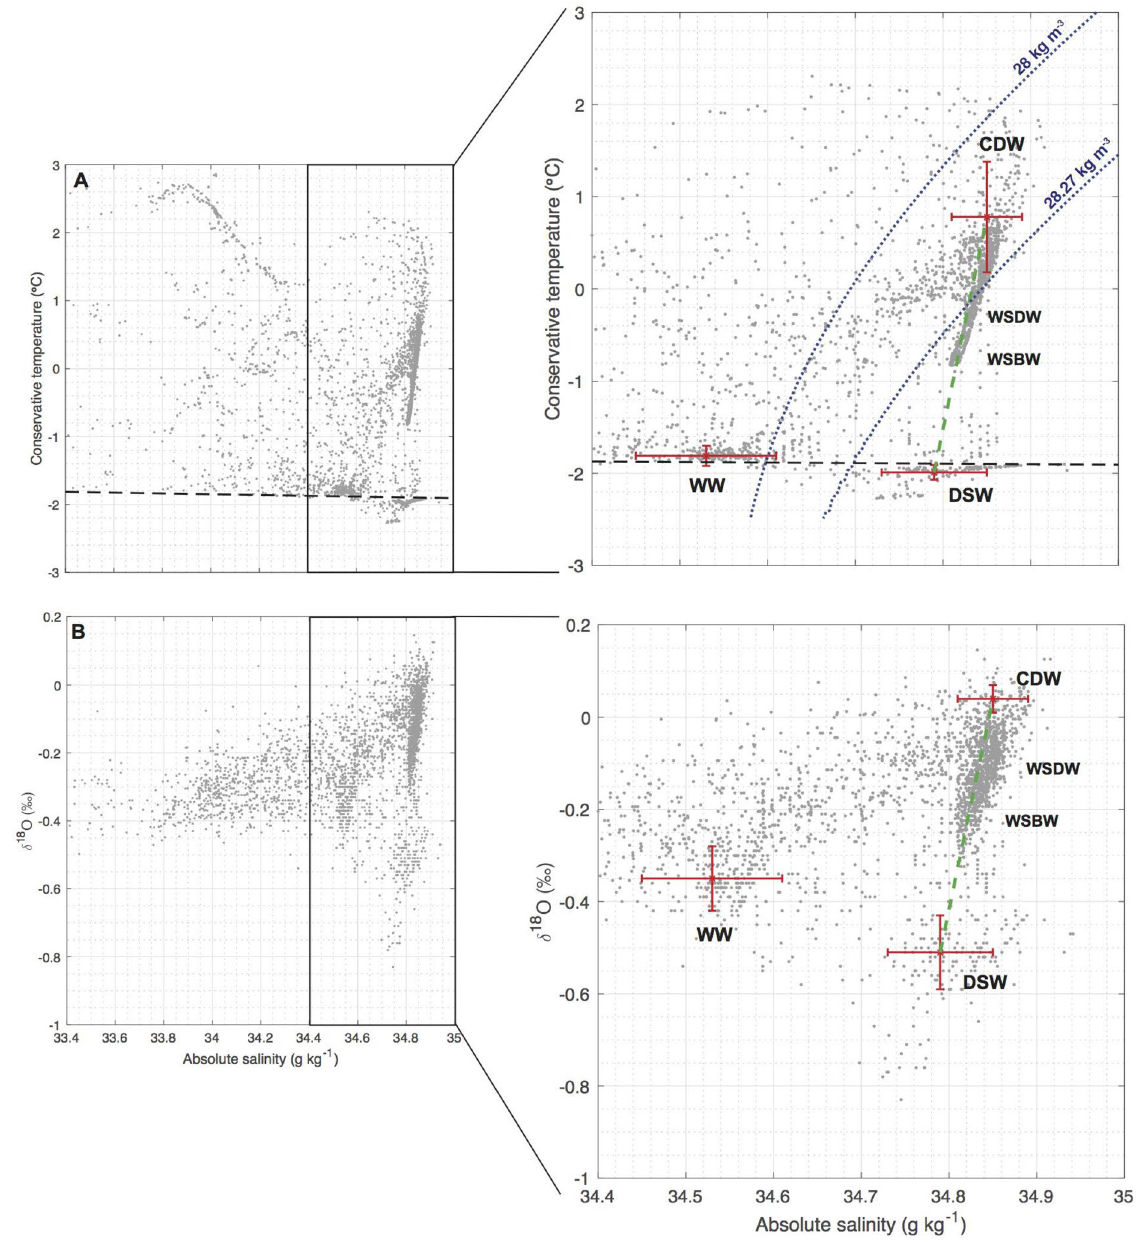
18 Figure 2. ( A ) (cid:31) -S A and ( B ) δ O–S A diagrams showing observations from the compiled dataset used in this study (see Fig. 1B; the Methods section). Neutral density surface 28 and 28.27 kg m − interface are superimposed as blue dashed curves in panel A; and surface freezing line as black dashed line. Mean and standard deviation of “source” water-masses (CDW, DSW and WW) characteristics are indicated as red